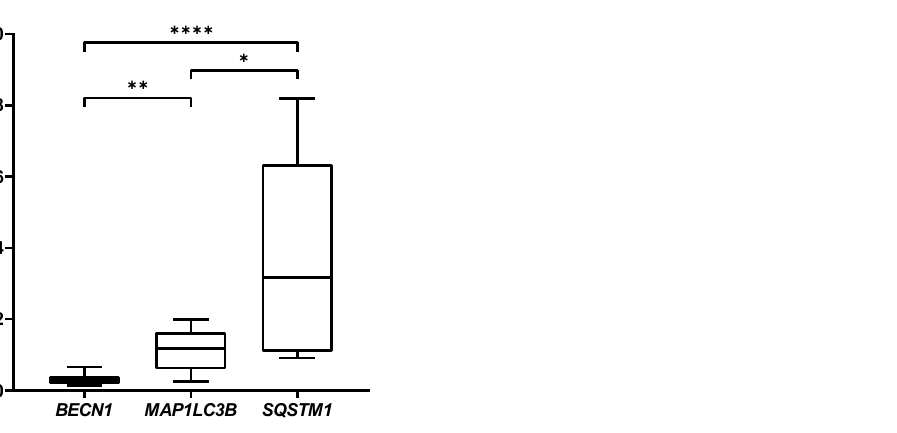
Figure 4. Real-time PCR analysis of BECN1, MAP1LC3B, SQSTM1 genes of hASCs embedded in VG-RGD hydrogel at day 2. Data were expressed as % GAPDH (housekeeping gene) and represented as a boxplot with median, minimum, and maximum. Kruskal–Wallis with Dunn’s multiple comparisons test was used for statistical analysis: * indicates differences between autophagic markers; * p < 0.05, ** p < 0.005, **** p < 0.0001.